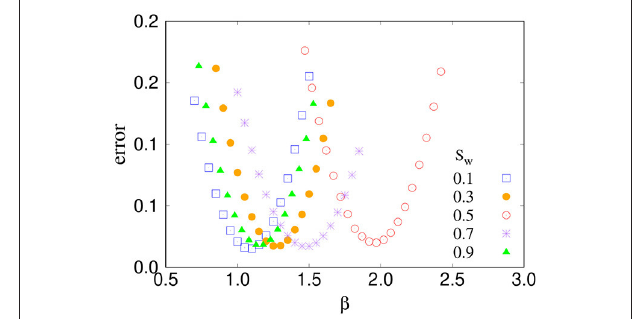
FIGURE 1 | Distributions of link radii r j for different values of the power α and width δ . For α 0 all the radii within the interval have equal probability = whereas for positive and negative values of α there is higher probability to have narrow and wide links, respectively.